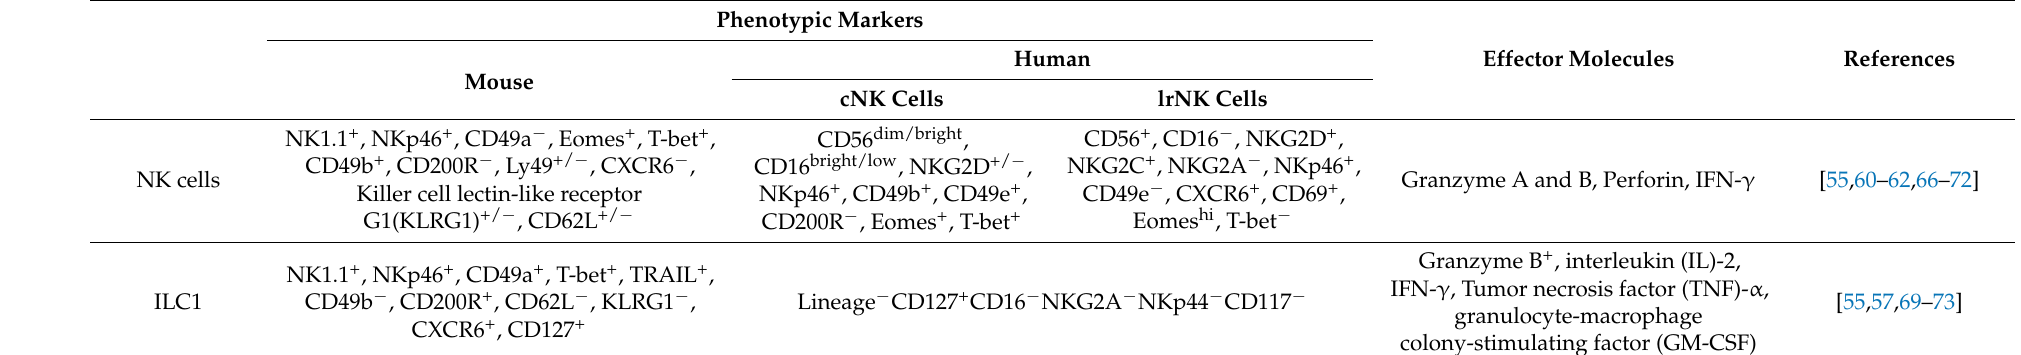
Table 1. Phenotypic and functional characteristics of human and mouse hepatic NK cells and